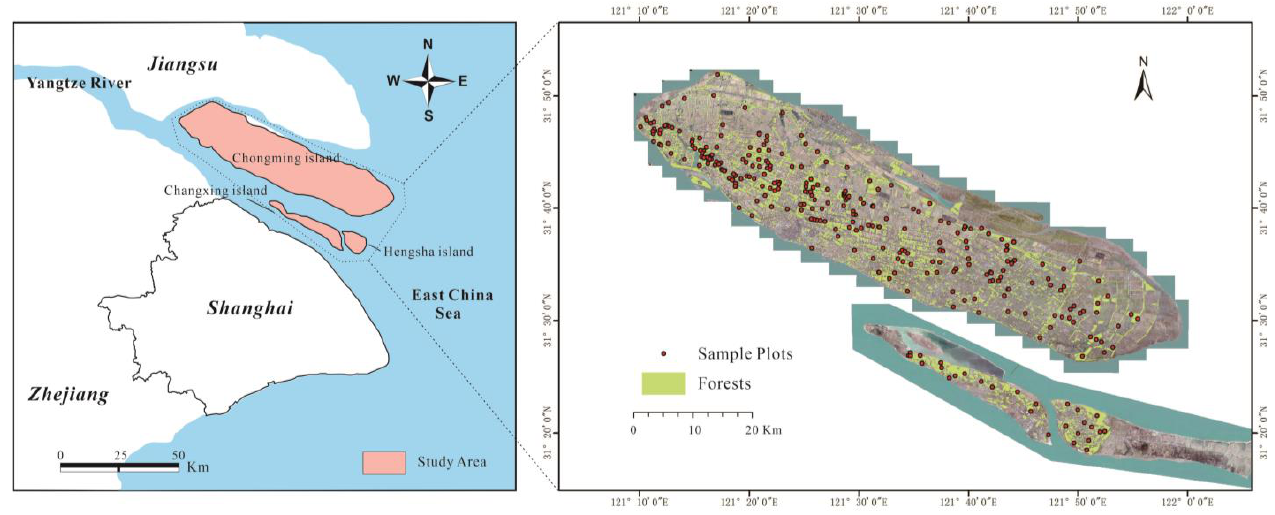
Figure 1. Geographical location of Chongming eco-island and the spatial distribution of forests (green part) and field sample plots (red dots) on the eco-island.